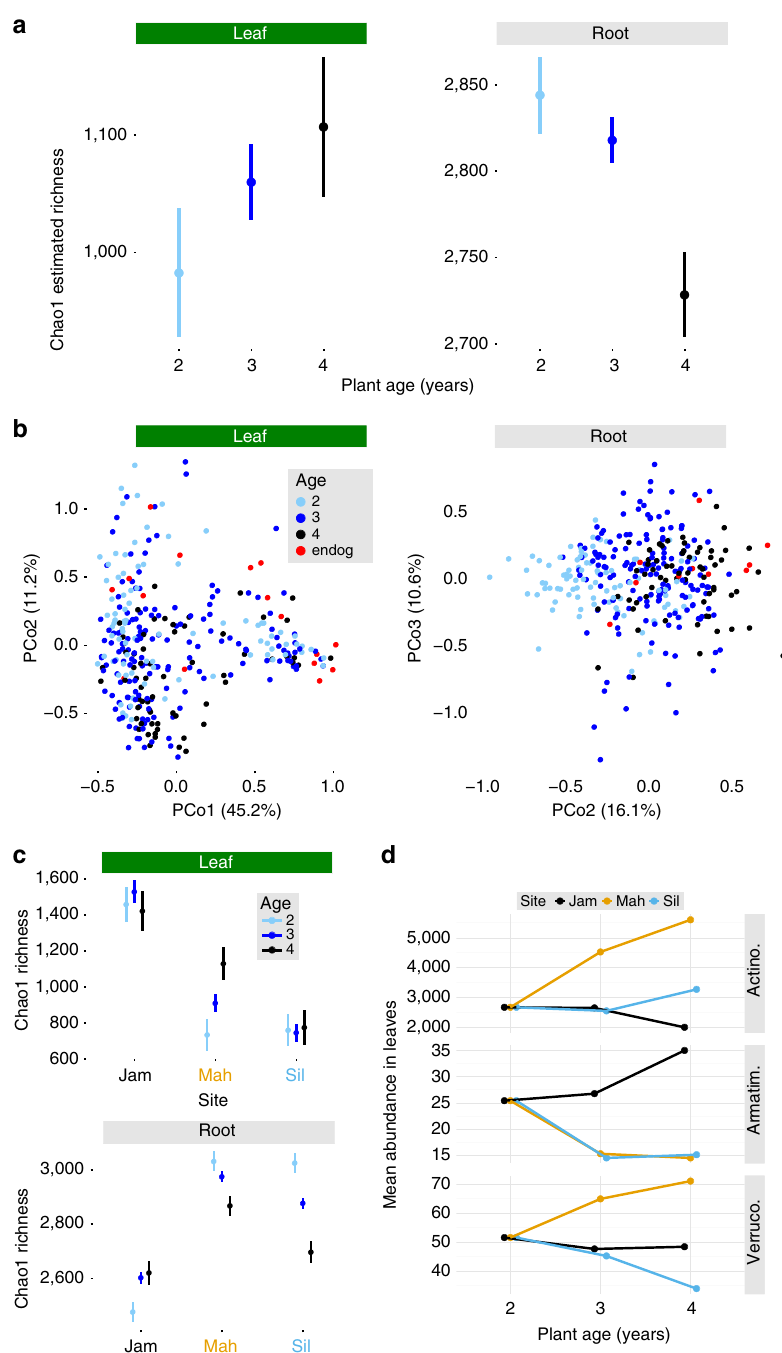
Figure 4 | Leaf- and root- associated bacterial communities change as plants age. Detailed statistics for all tests are found in Tables 1 and 2. Sample sizes are N ¼ 306 for leaves and N ¼ 310 for roots. ( a ) Within-sample diversity declines with age in roots (ANOVA, F 2,57 ¼ 6.08; P ¼ 0.0081) but not in leaves (F 2,64 ¼ 1.11; P ¼ 0.67). Least-squares mean diversity estimates are plotted to show the effect of age after controlling for other sources of variation. Bars depict 1 s.e.m. ( b ) PCoA of weighted UniFrac distances between samples reveals that root bacterial community composition shifts over the lifetime of the plant. In roots, communities of experimental plants become more similar to those of endogenous plants, suggesting a role of succession after transplant (see Supplementary Note 2 for a detailed treatment of this hypothesis). Detailed statistics for the top three PCoA axes are found in Table 2. ( c ) Least-squares mean estimates of Chao1 richness are plotted for each age group in each site, illustrating how the distinct plant-associated bacterial communities in these habitats respond differently to host age. Leaves: F 4,63 ¼ 1.48; P ¼ 0.36. Roots: F 4,56 ¼ 7.85; P ¼ 8.6e (cid:2) 5. Error bars depict 1s.e.m. ( d ) In leaves, the effect of plant age on the abundance of several phyla differs among sites (Likelihood ratio test, P o 0.05 after Benjamini–Hochberg correction for multiple comparisons). Estimated mean abundances from NBMs are plotted for each age group at each site. ‘Actino.’ ¼ Actinobacteria; ‘Armatim.’ ¼ Armatimonadetes; ‘Verruco.’ ¼